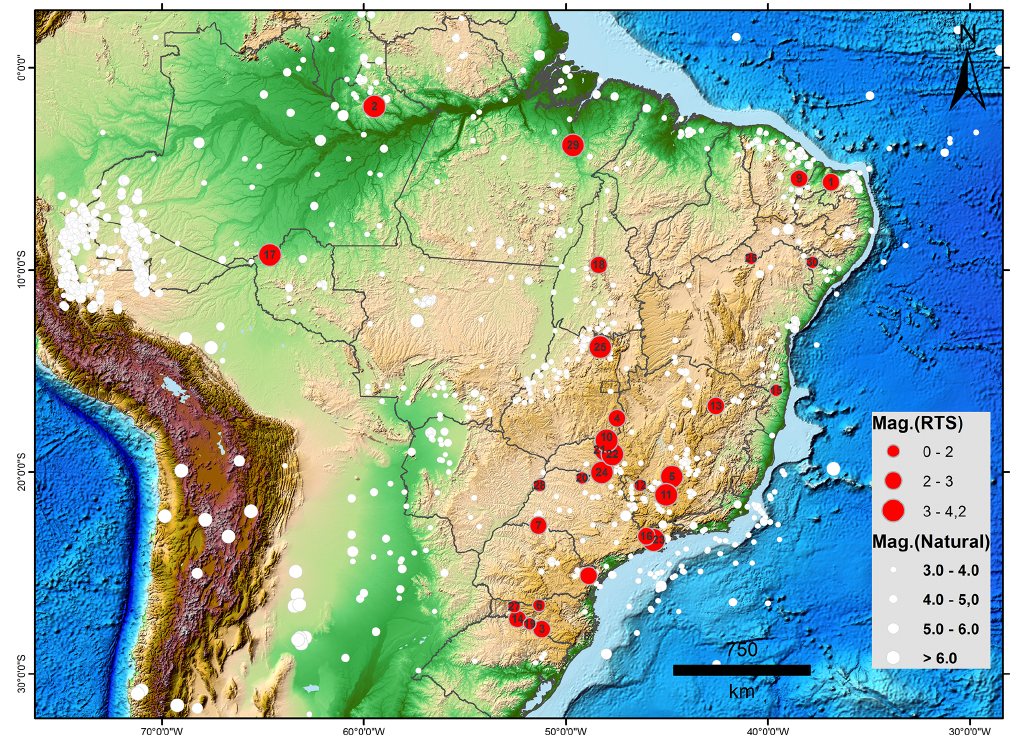
Figure 6. Map of Brazil showing natural earthquakes (white circles, with magnitude) and RTS in Brazil (red circles, with magnitude, numbered as stated by Table 2). Data from the bulletin of the IAG-USP and SISBRA-UnB.